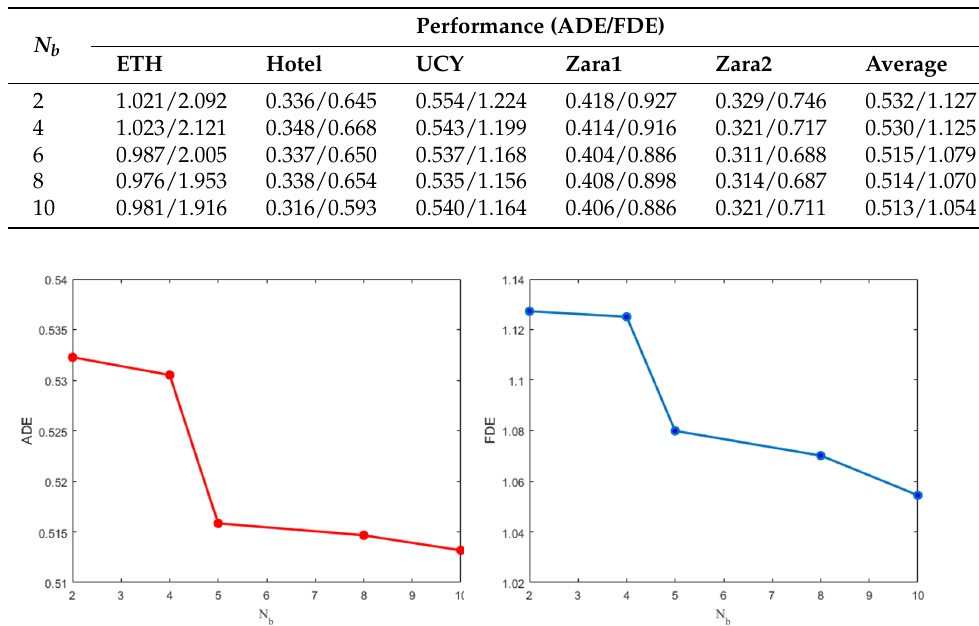
Figure 3. Results comparison of average ADE ( left ) and FDE ( right ) on different numbers of layers N b . With the increase of blocks, ADE and FDE gradually decreased. ADE and FDE tend to be stable when N b increases to 6. Thus, considering the balance between performance and computation, the number of blocks layers is set to 6 in the modular